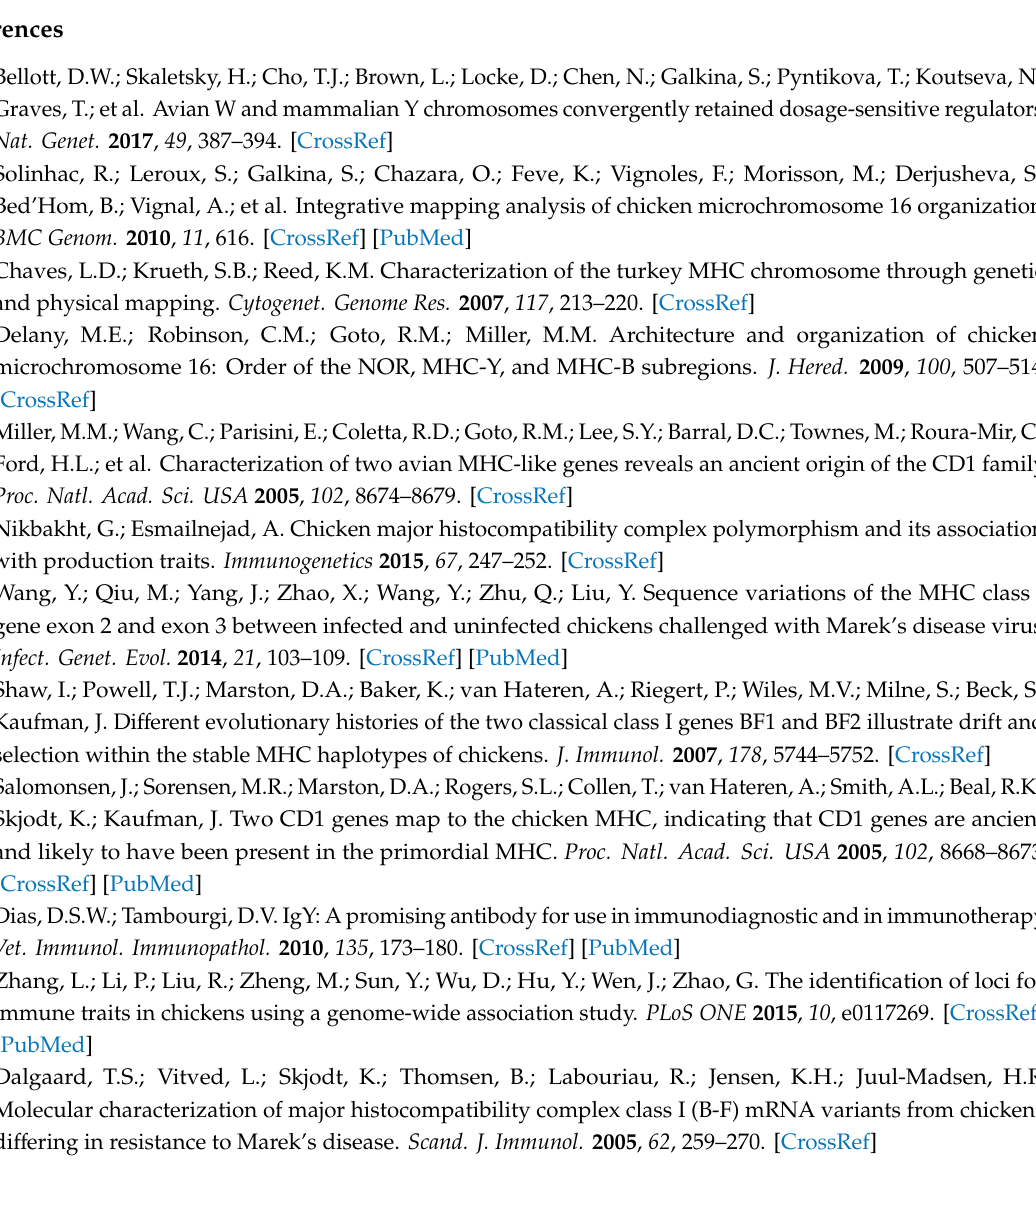
Table S1: the unique SNPs in Beijing-You chickens, Table S2: the unique SNPs in White Leghorn chickens, Table S3: the unique Indels in Beijing-You chickens, Table S4: the unique Indels in White Leghorn chickens, Table S5: SNPs related to high-IgY level in both varieties, Table S6: SNPs related to low-IgY level in both varieties, Table S7: Indels related to high-IgY level in both varieties, Table S8: Indels related to low-IgY level in both